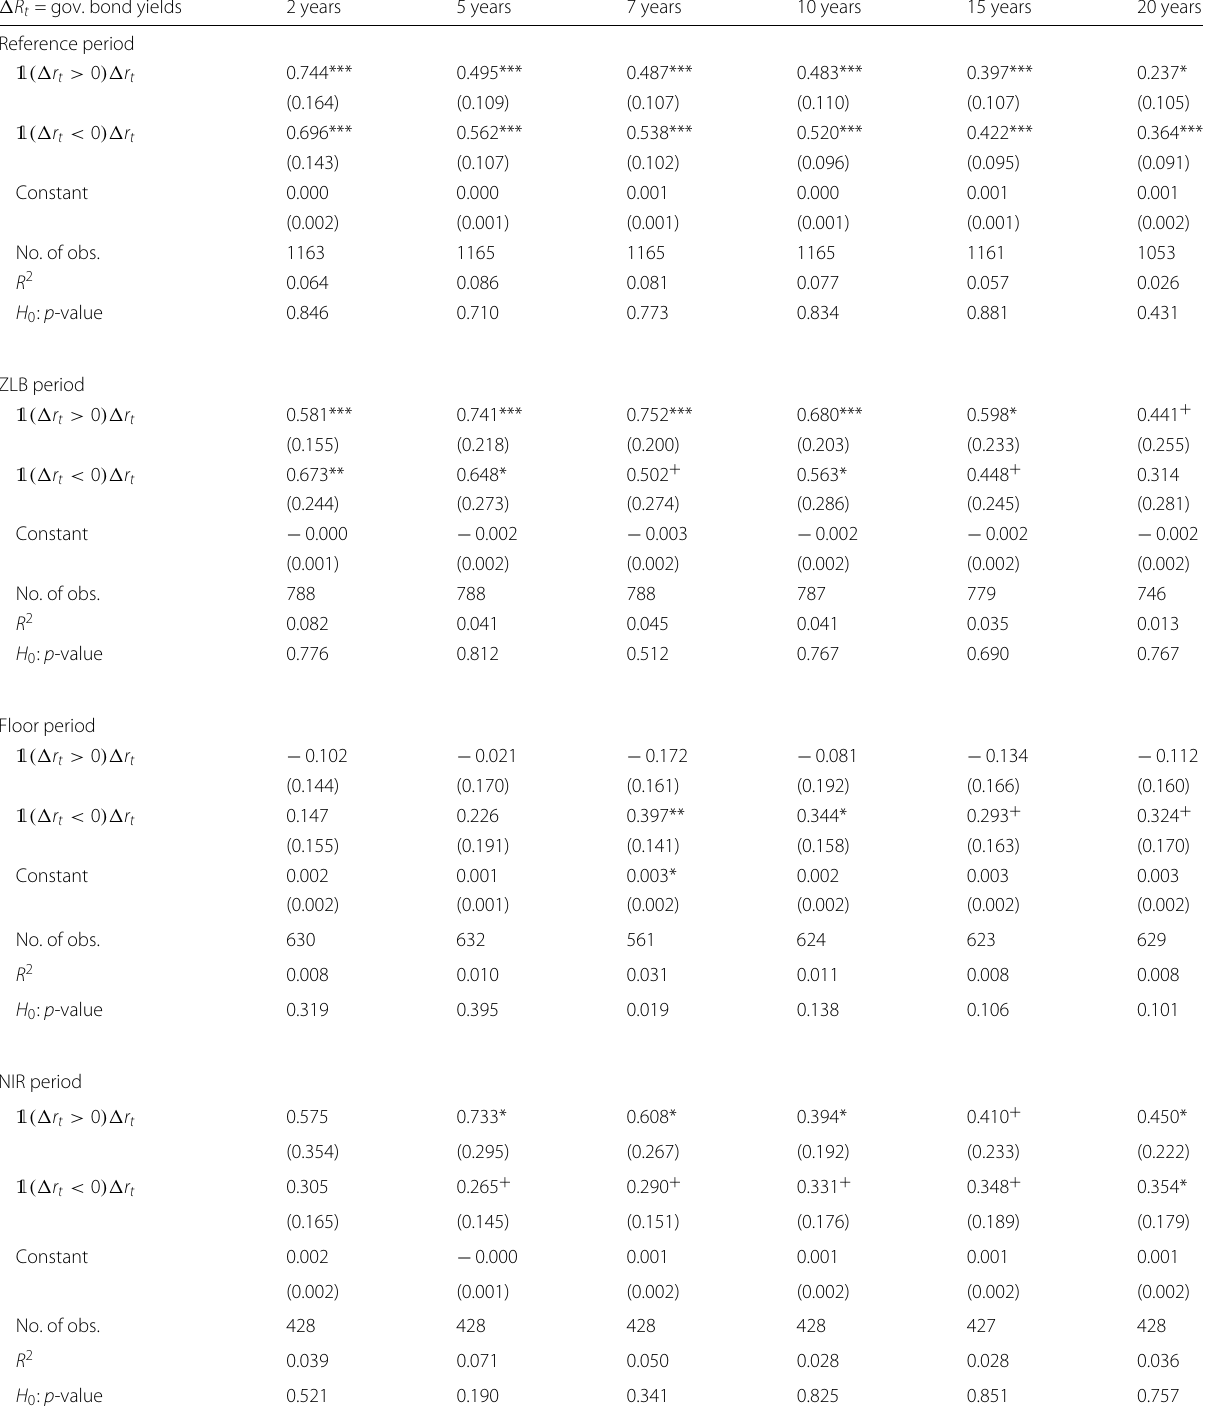
Table 6 Robustness: accounting for